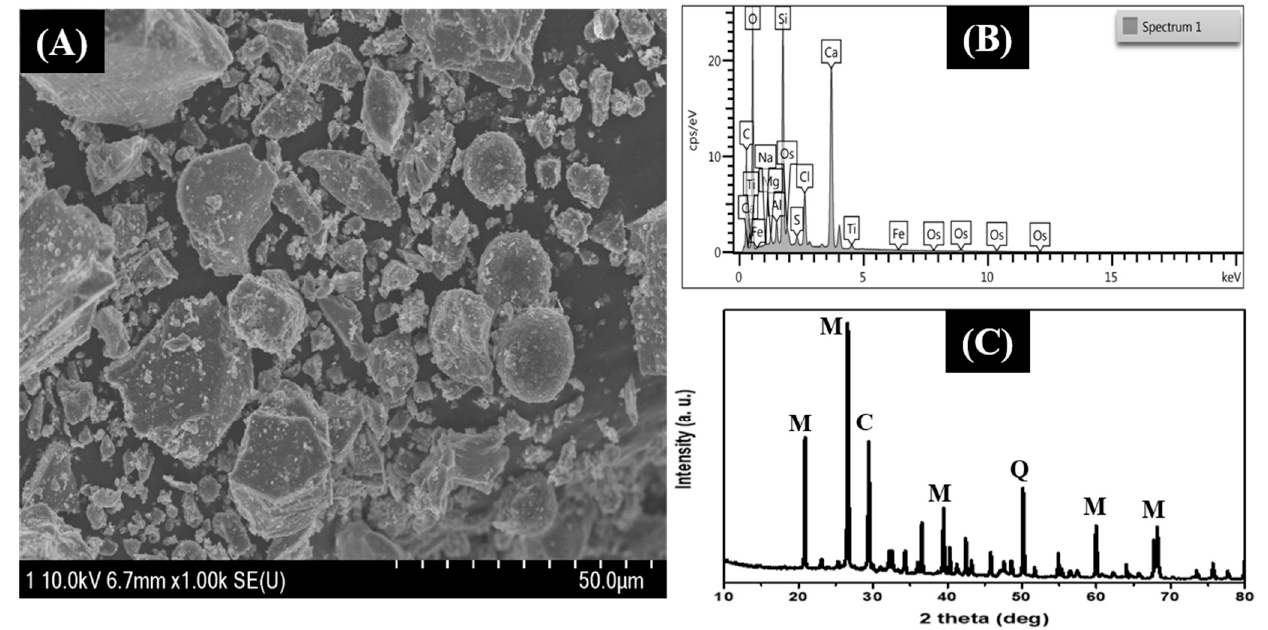
Figure 2. FESEM ( A ), EDS ( B ), XRD spectra ( C ) of FA particles.